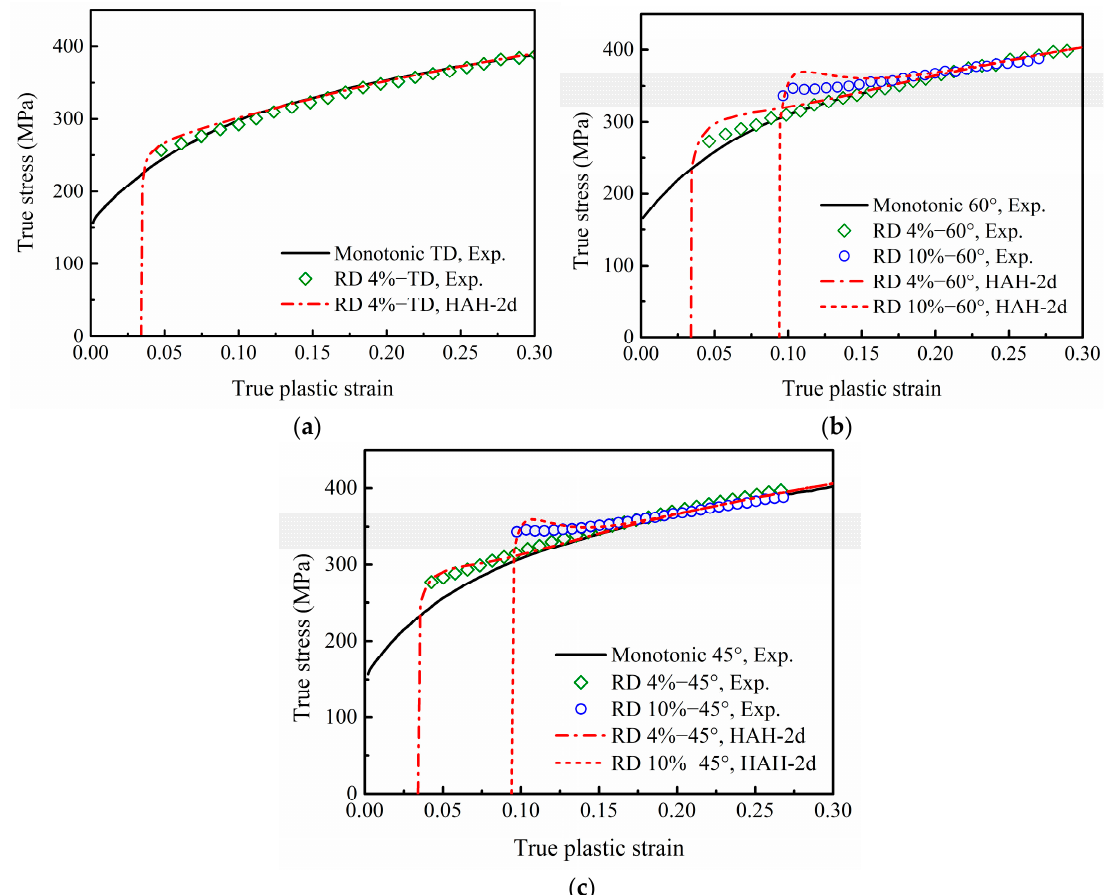
Figure 17a–c show the predicted reloading flow stress curves for EDDQ in different two-step uniaxial tensions with pre-tension in RD and re-tension at 90 ◦ (TD), 60 ◦ and 45 ◦ from RD. The predicted curves capture all the experimental results well, even though there is a little overestimation of the flow stress in the re-tension at 60 ◦ from RD. The corresponding prediction errors are listed in Table 5. The maximum values of RMSE and AARE, 9.86 and 2.00%, both occur in the condition of re-tension at 60 ◦ after a 10% pre-tension. This indicates that the HAH-2d model can capture anisotropic hardening responses such as flow stress overshooting and strain-hardening stagnation.